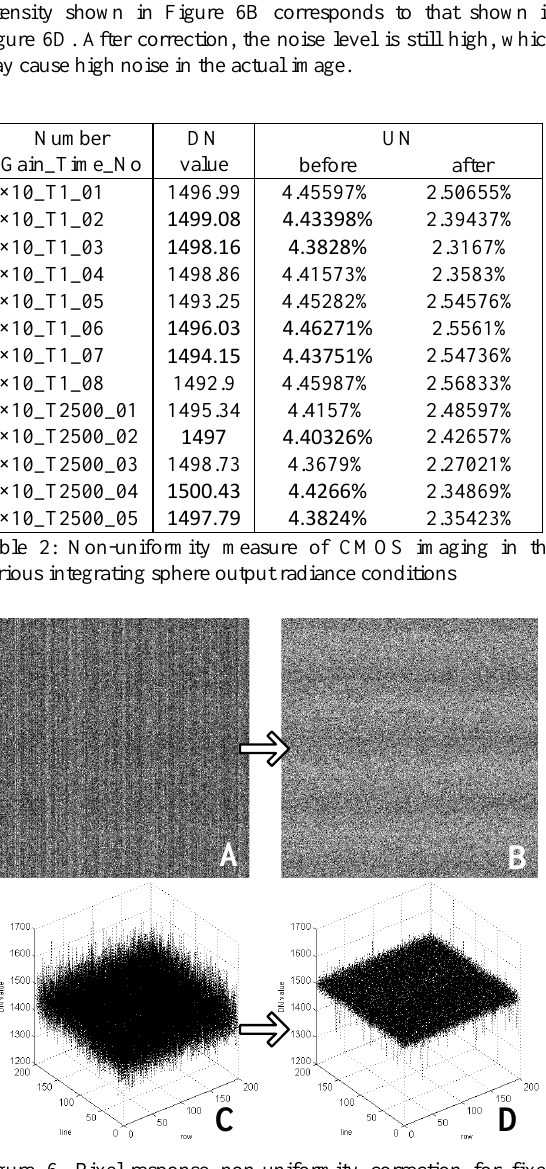
Figure 6. Pixel-response non-uniformity correction for fixed pattern system noise, A: Original image, 400 × 400 pixels, average DN value 1496; B: Correction result image; C&D: corresponds to A&B’s 3D